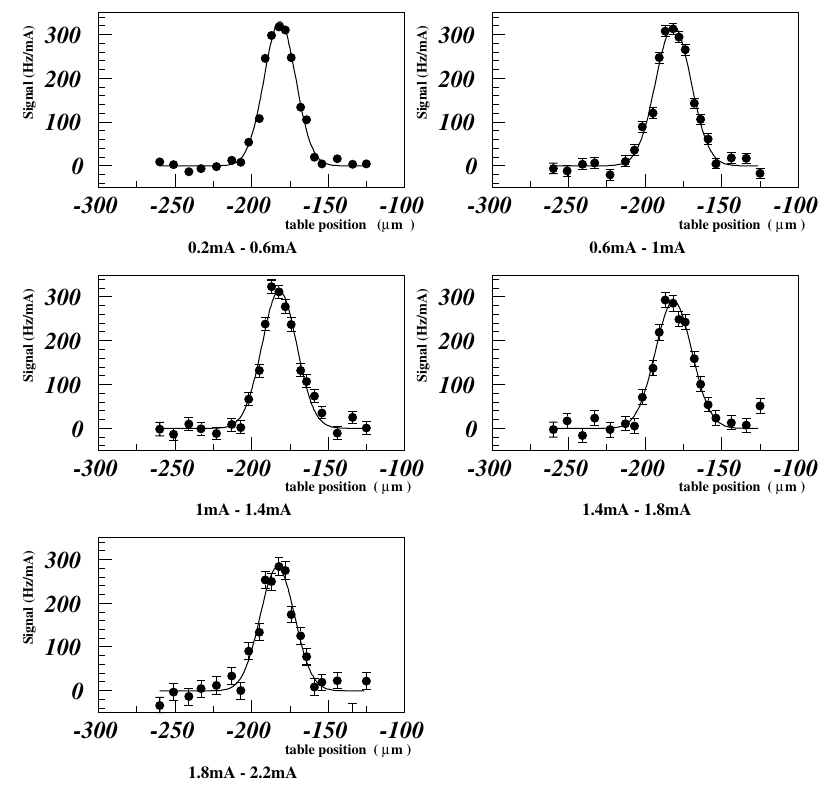
FIG. 9. Normalized signal count versus the laser wire position. The plots are the combined data of the energy interval 5–25 MeV for five different electron currents (labeled by the subtitle at the bottom) taken on ( 2000 = 12 = 05